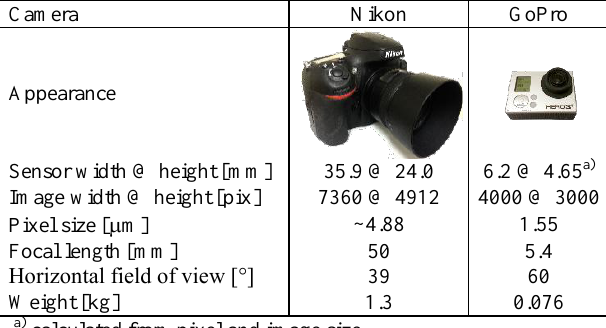
Table 3. Parameters of the used cameras